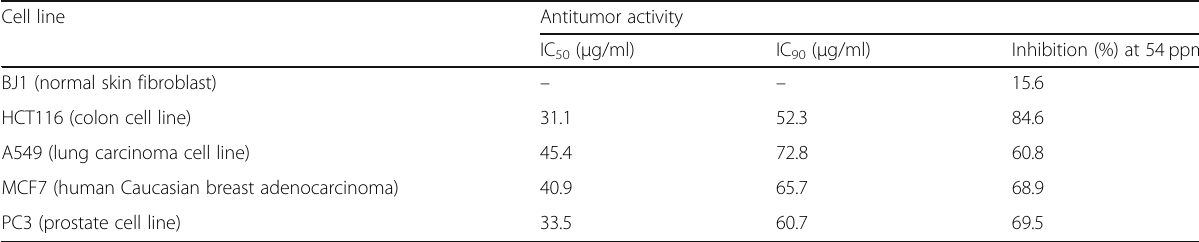
Table 2 Antitumor activity of the biosynthesized AgNPs Cell line